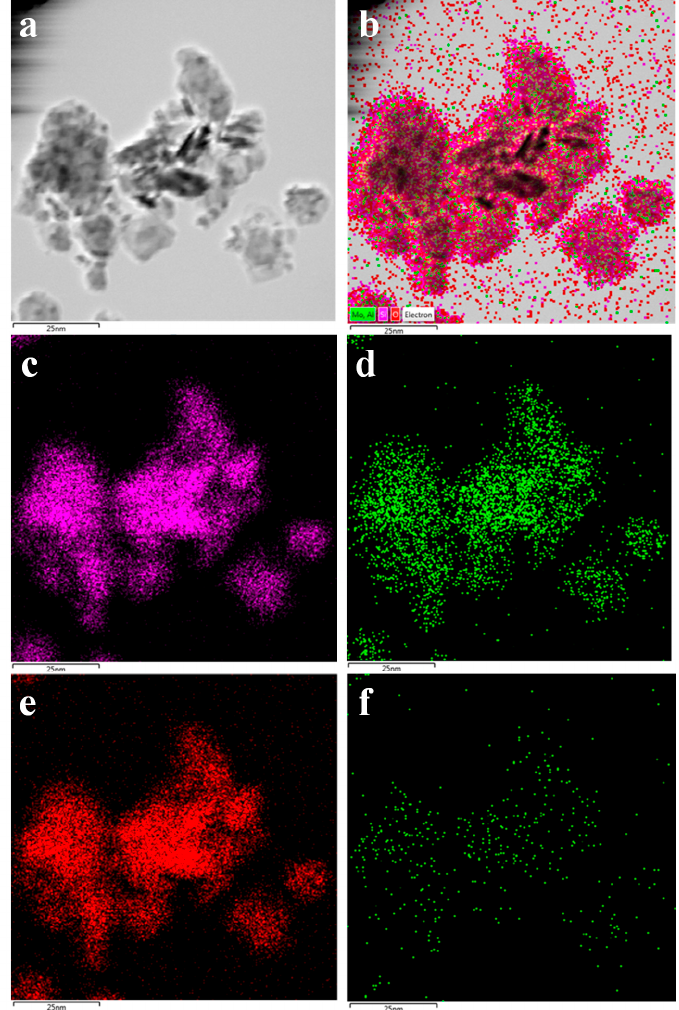
Figure 7. TEM image of 6Mo(N)-HMCM-49 used in the EDS mapping test ( a ), and the corresponding EDS mapping of various elements ( b ), Si ( c ), Al ( d ), O ( e ), and Mo ( f ).